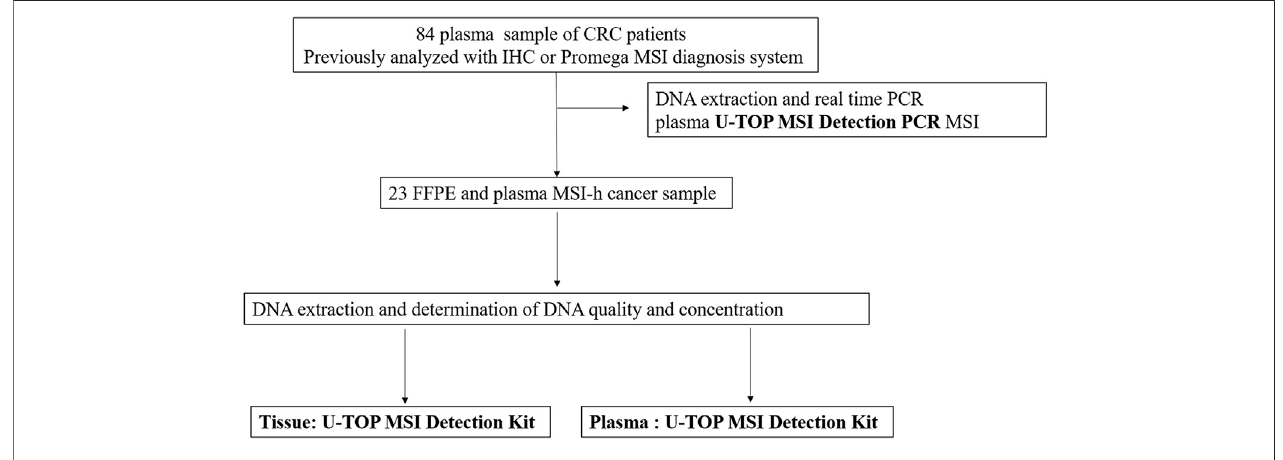
FIGURE 3 | Flow chart of the